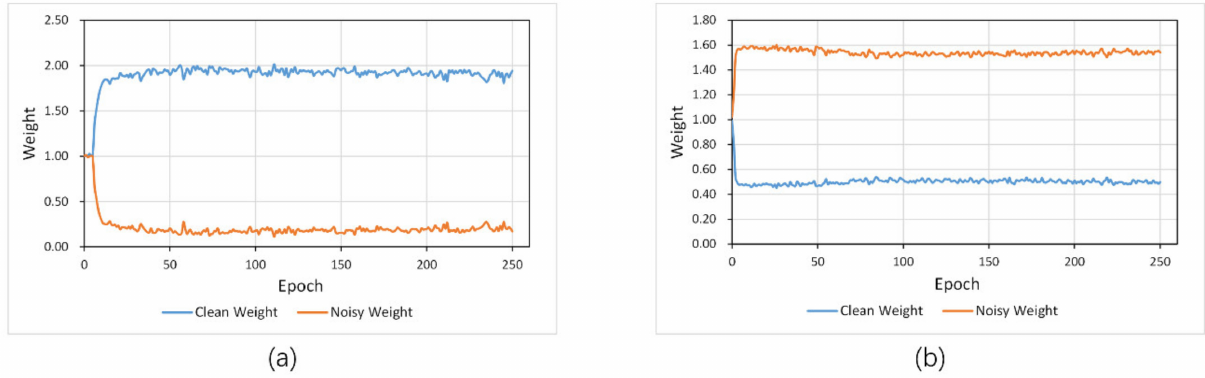
Figure 12. Average weights of clean-label samples and noisy-label samples during the training of the network at a noise rate of 50%. ( a ) Dilated noise, ( b ) eroded